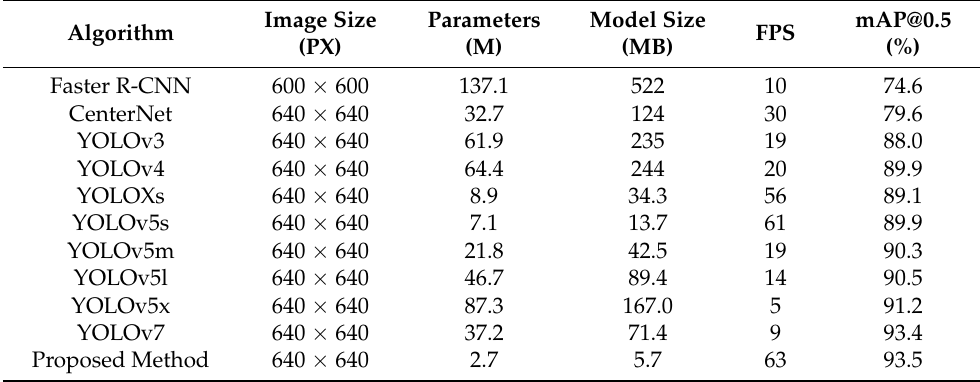
Table 5. Comparison of mainstream